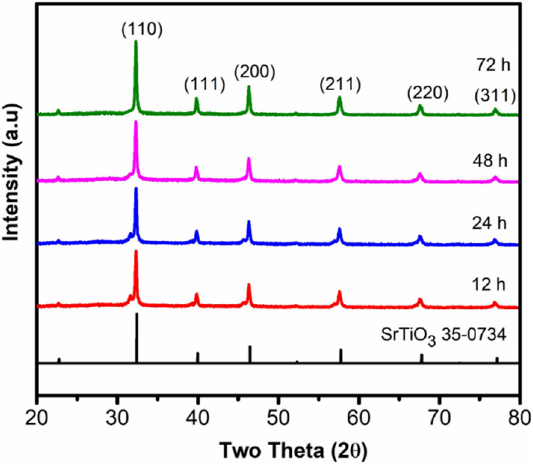
Figure 1. XRD pattern of SrTiO 3 photocatalysts at hydrothermal temperatures of 130 °C.